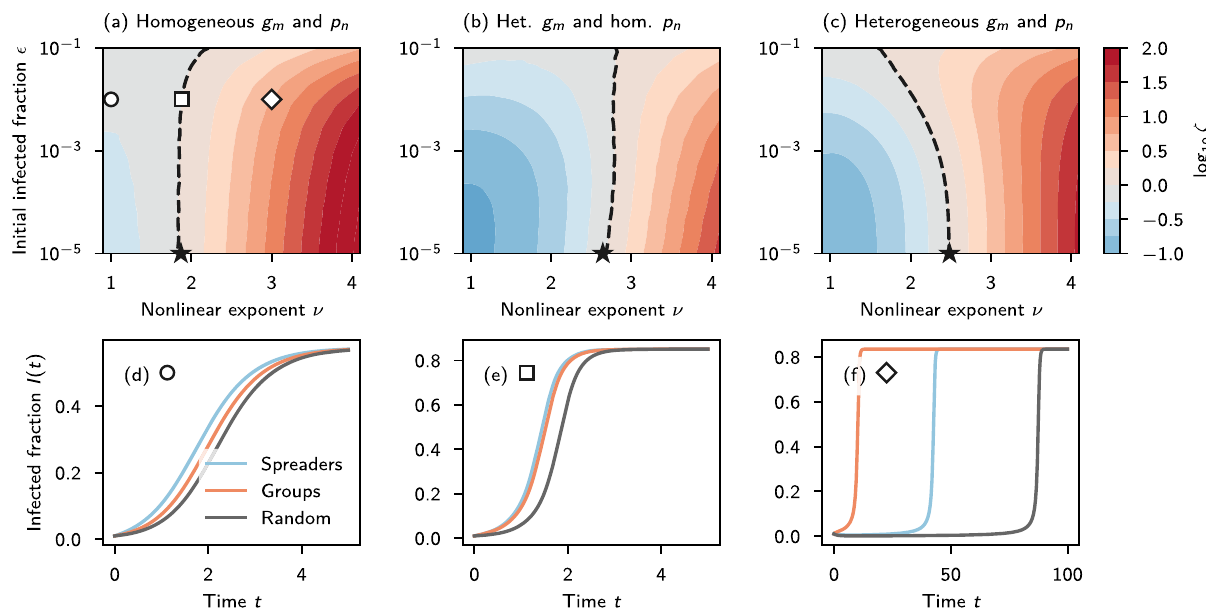
Fig. 10 Comparison of the in fl uential spreaders and in fl uential groups strategies. a – c If log 10 ζ > 0, this indicates that the in fl uential groups strategy is better to maximize _ I , and vice versa if log 10 ζ < 0. We use different combinations of homogeneous and heterogeneous distributions. More speci fi cally, for homogeneous distributions we use g m ∝ a m e − a / m ! and p n ∝ a n e − a / n !, with a = 5, m min ¼ 1, n min ¼ 2, and m max ¼ n max ¼ 20. For heterogeneous distributions, we use g m / m (cid:2) γ m and p n / n γ n , with γ m = γ n = 3, m min ¼ n min ¼ 2, and m max ¼ n max ¼ 100. The dashed lines indicate when ζ = 1 and the star markers correspond to the limit ϵ → 0, using Eq. (32). Irregularities of the level curves are due to the discrete nature of g m and p n , not to numerical errors. d – f Time evolution of the fraction of infected nodes for different strategies, with ϵ = 10 − 2 and ν ∈ {1, 1.88, 3}, corresponding to the three empty markers in a . We use λ = 3 λ c in each case. The random strategy corresponds to s m = 1 − ϵ for all m , and f n , i is a binomial distribution with probability ϵ